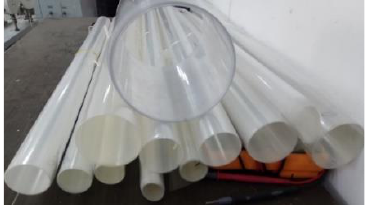
Figure 4. PET films with different thicknesses.